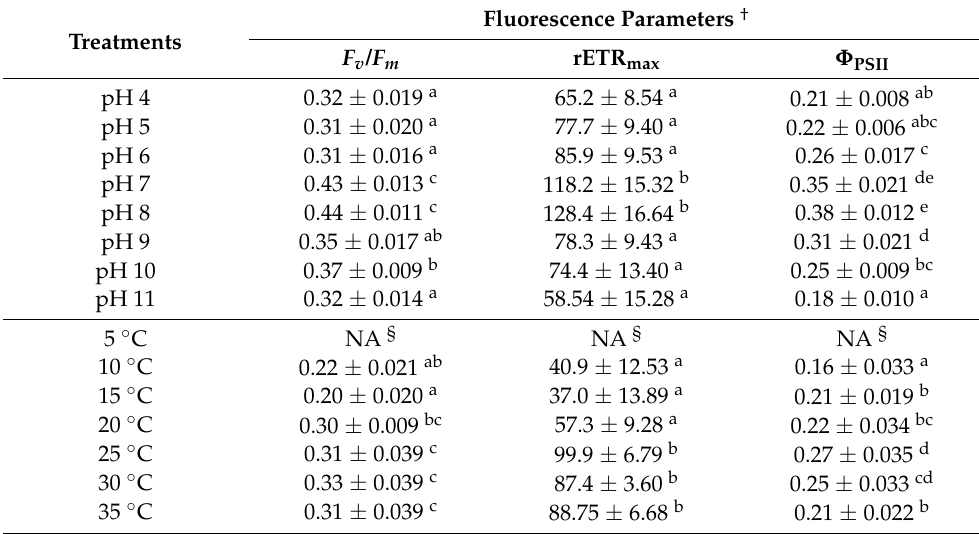
Table 1. Values of the fluorescence parameters in Arthrospira maxima cultures grown under different pH and temperature treatments. Fluorescence Parameters Treatments